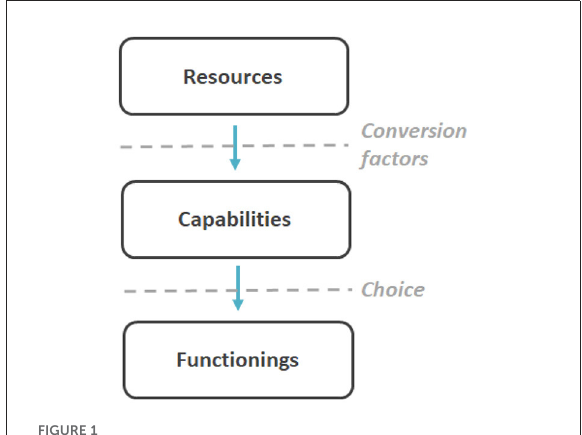
FIGURE1 Conceptual framework of the capabilities